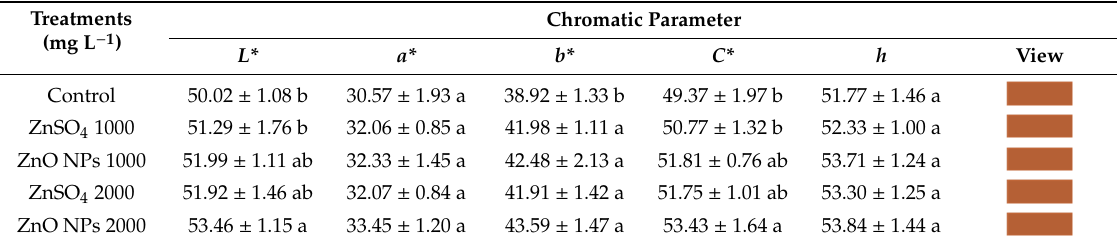
Table 2. Chromatic characteristics in habanero pepper fruits obtained from plants treated with ZnO NPs and ZnSO 4 .